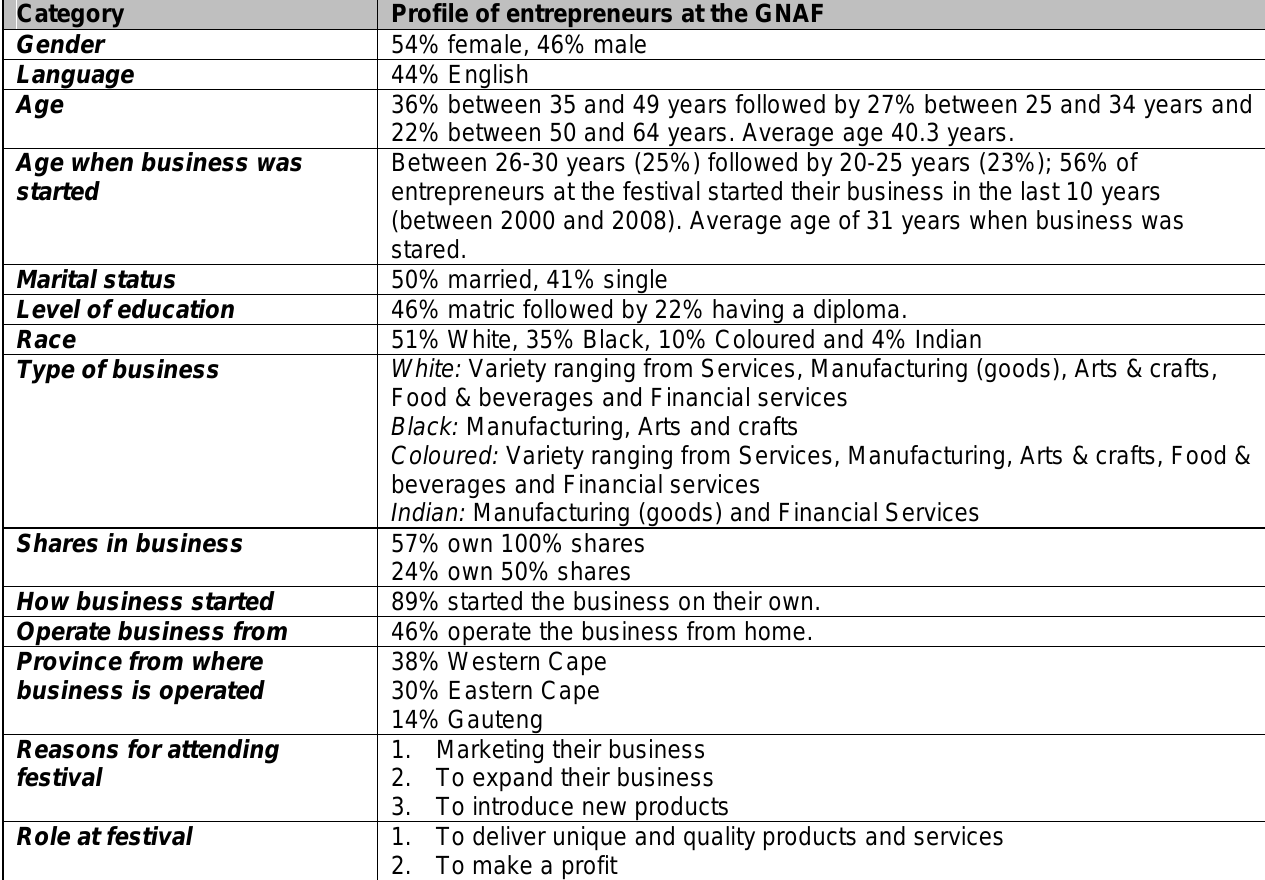
Table 4: Profile of entrepreneurs at the